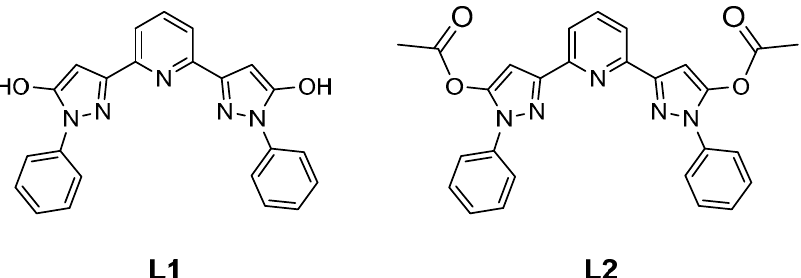
Scheme 2. Ligands in this study: L1 , 2,6-di(1-phenyl-5-hydroxy-1 H -pyrazol-3-yl)pyridine and L2 ,